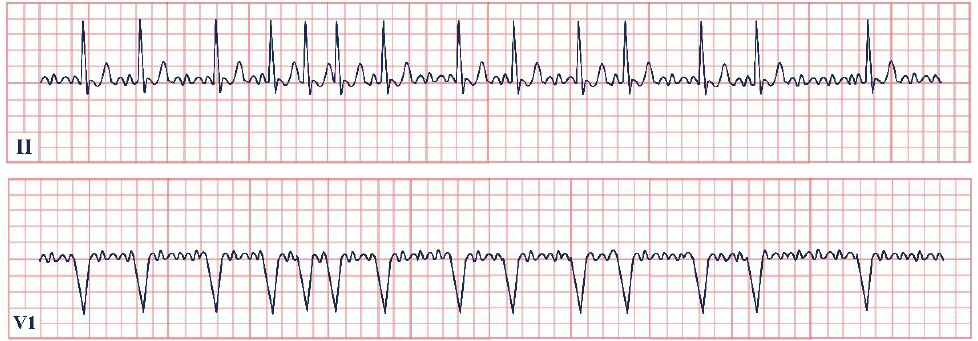
Figure 10. Electrocardiogram aspect in PAFIYAMA